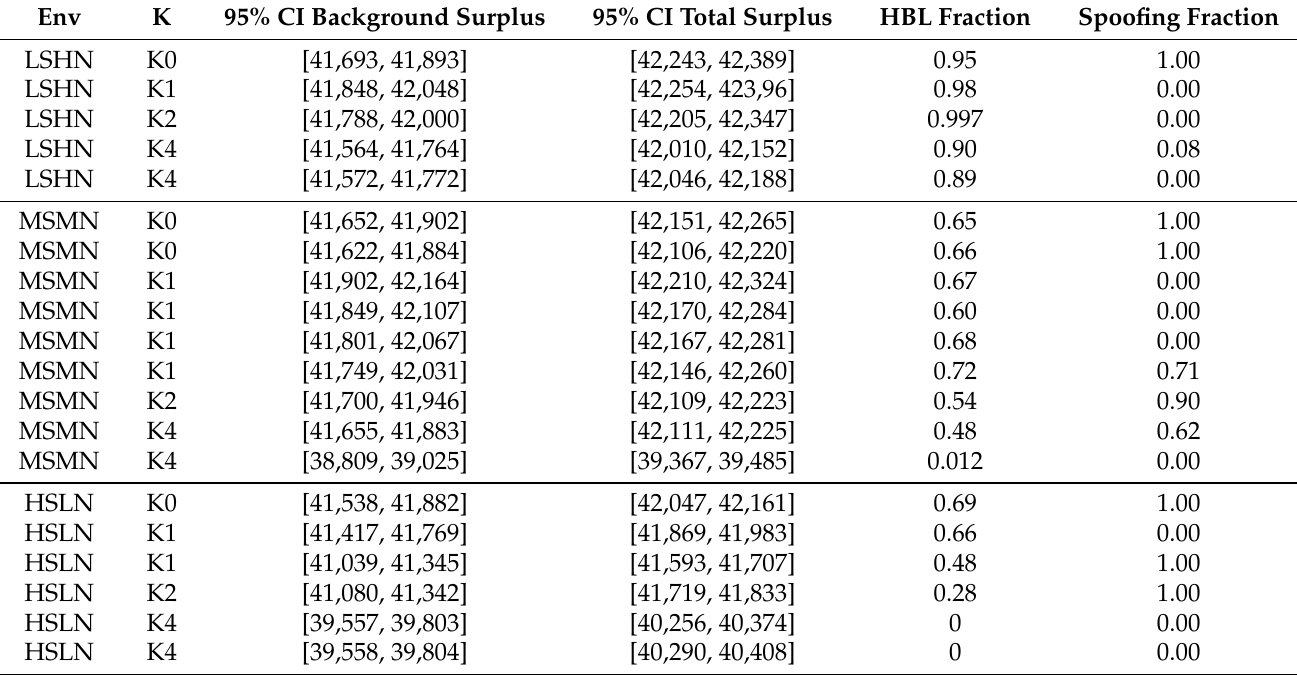
Table A14. Equilibria for games where the exploiter strategically chooses to spoof. Each row of the table describes one equilibrium found with its corresponding background surplus, total surplus, HBL and spoofing adoption rate. The results reported are based on at least 20,000 simulation